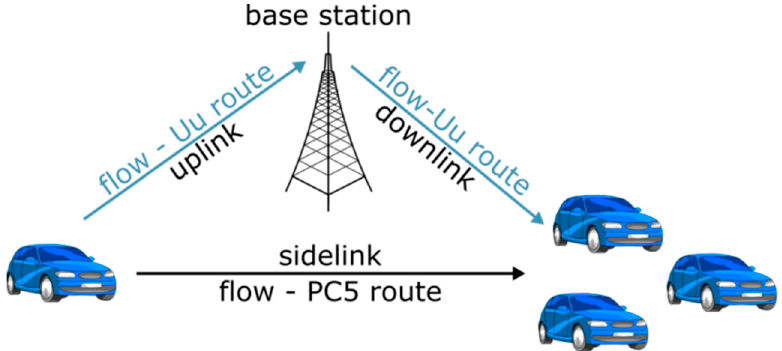
Figure 12. Redundant scheduler, illustrating the Uu and PC5 routes.